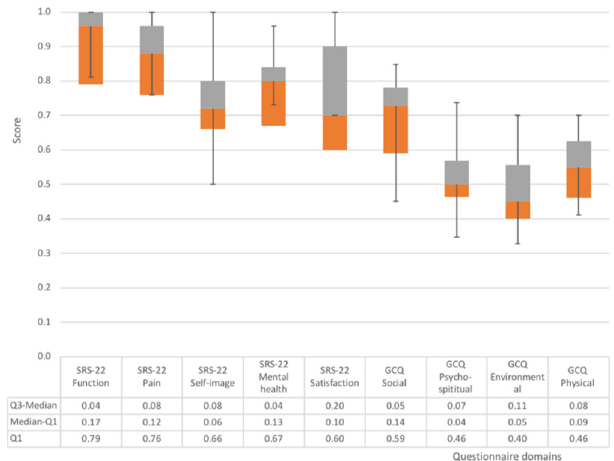
Figure 4. Box-whisker plot for the SRS-22 and GCQ domain scores.